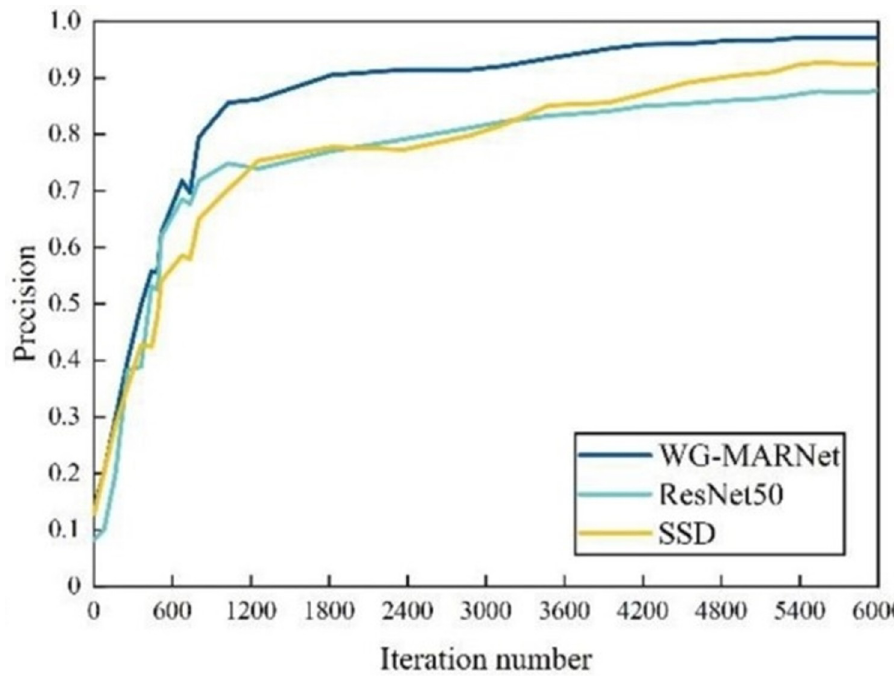
Fig 12. The precision curves of different classification and detection algorithms varying with the iteration number.